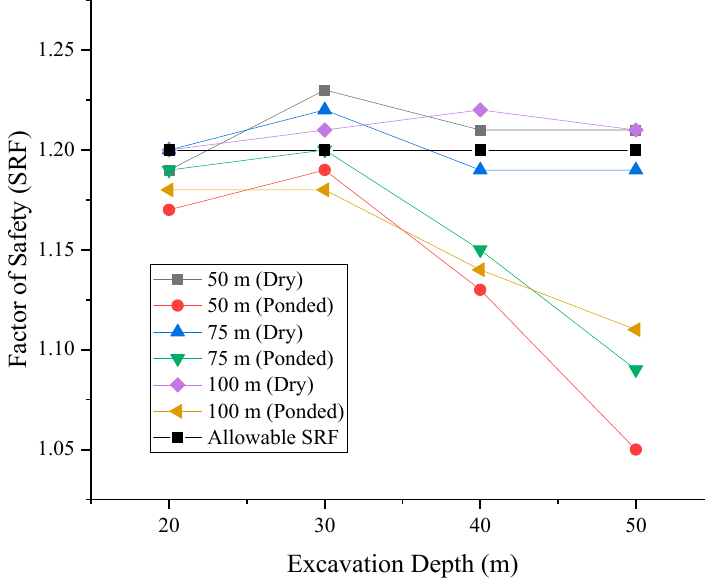
Figure 15. Variation in safety factor with excavation depth.